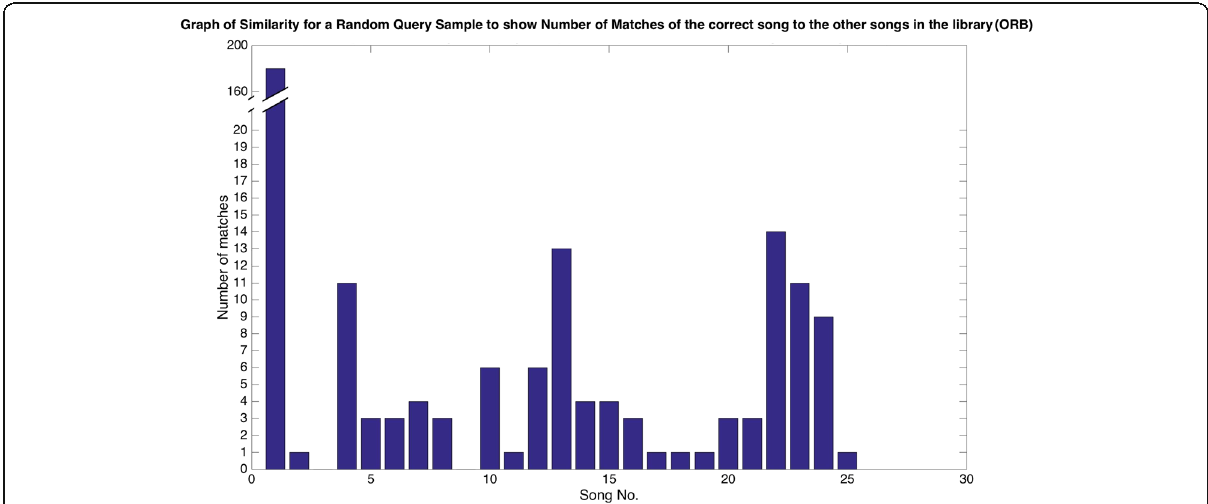
Fig. 8 Test for similarity of unknown sample to songs in the database (ORB). In this figure, it was seen that a random 20-s sample clip was taken from a song in the database and queried using the ORB prototype. This test was done to show and compare the number of matches the query had to each song in the library. Results showed that the number of matches for the corresponding song was large compared to the matches of the query found in other songs in the database. This justified the reliability of the ORB prototype